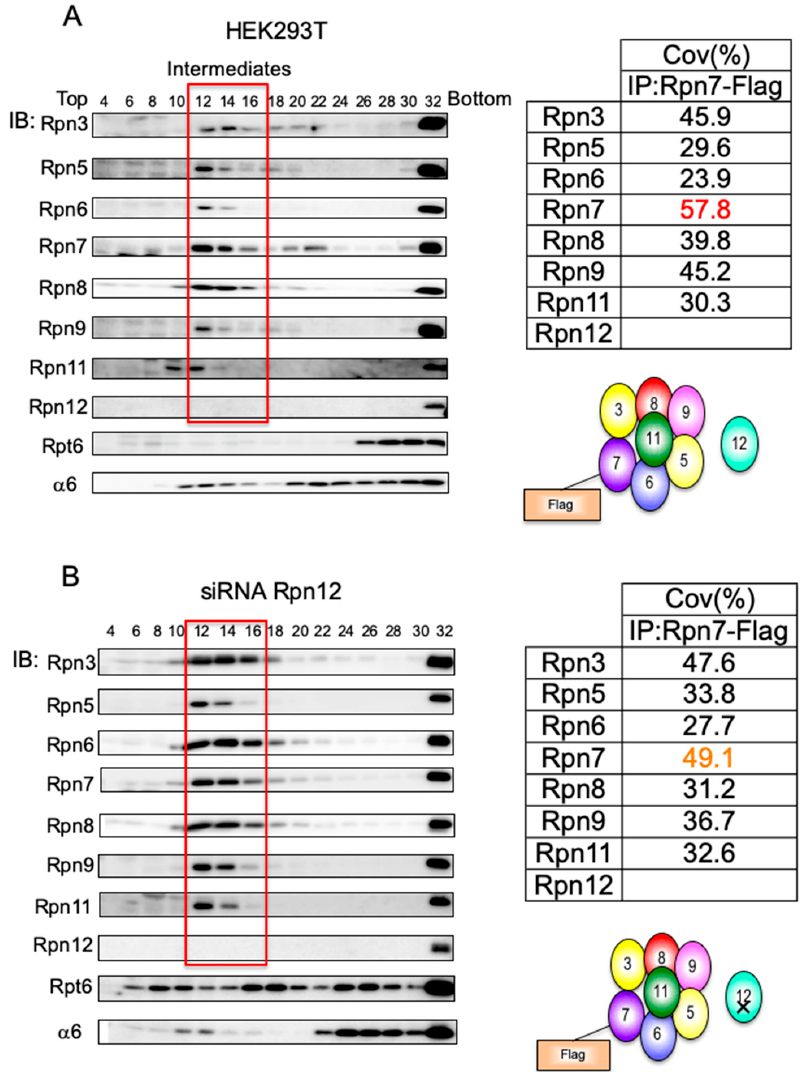
Figure 2. Rpn12 is incorporated at the final step of lid formation. ( A ) HEK293T cells stably expressing Rpn7-Flag were lysed and subjected to 4%–24% glycerol gradient centrifugation. The fractions were analyzed by immunoblotting with anti-Rpn3, Rpn5–Rpn9, Rpn11, Rpn12, Rpt6, and α 6 antibodies. Fractions corresponding to the accumulated complexes (boxed in red) were immunoprecipitated (IP) with the anti-Flag antibody. The precipitated complexes were analyzed by LC-MALDI followed by tandem mass spectrometry. The table shows the sequence coverage of the identified subunits. ( B ) siRNA targeting Rpn12 was transfected into HEK293T cells for 48 h and then analyzed as described in Figure